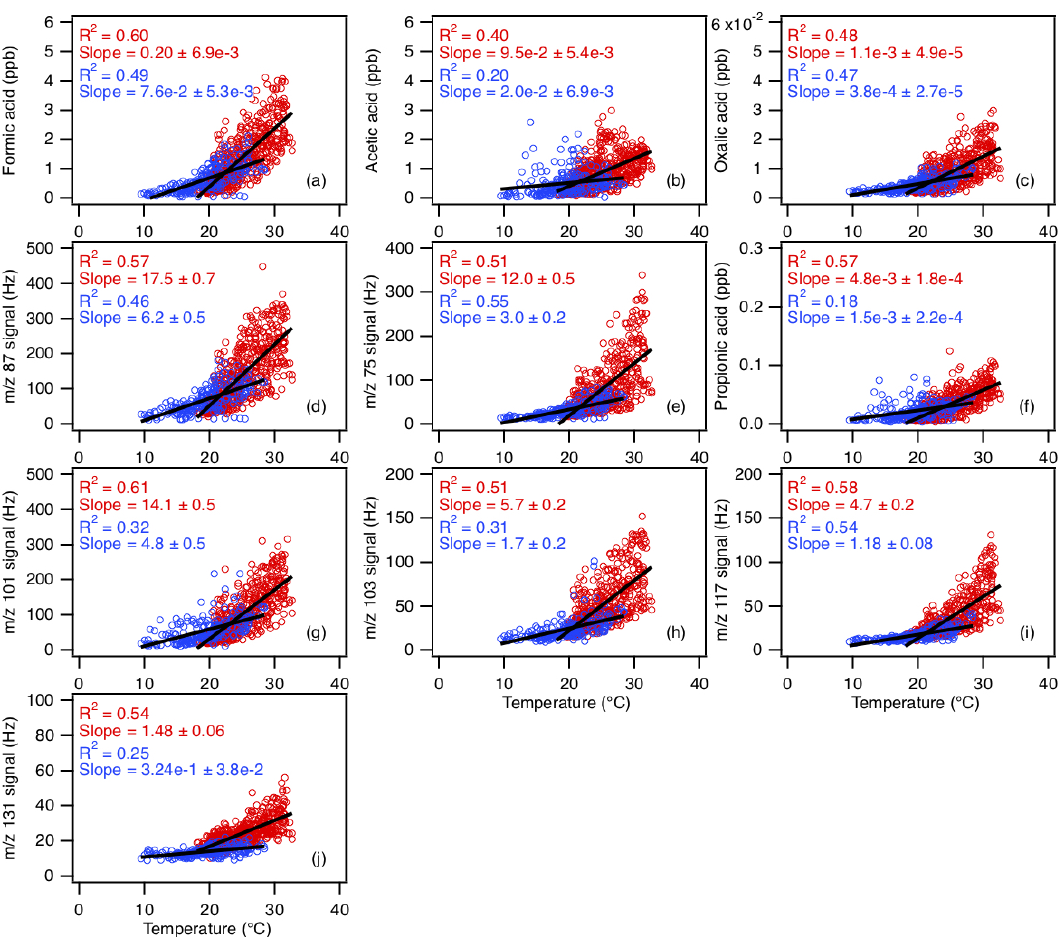
Figure 8. Scatter plots of concentrations (or ion signals) of the measured organic acids with ambient temperature. The red symbols are data collected from 3 to 27 September, while the blue symbols are data collected from 28 September onwards. All the data are displayed as 1h averages. Black lines shown are linear fits to the